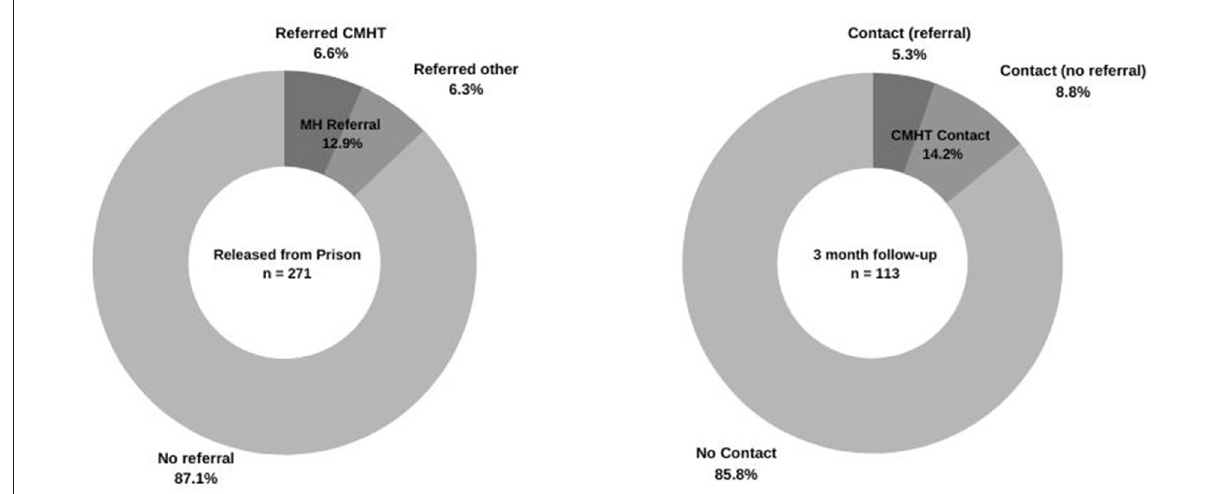
FIGURE2 Proportion of released participants who received a referral for mental health care, and proportion of those interviewed at follow-up who had contact with a Community Mental Health